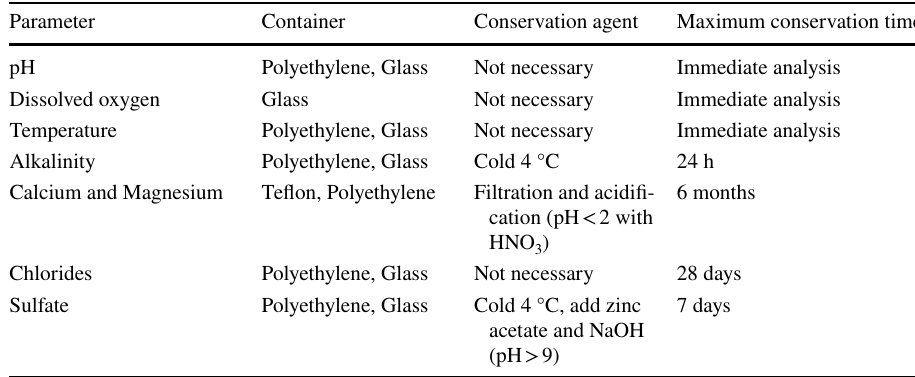
Table 1 Containers, techniques and storage